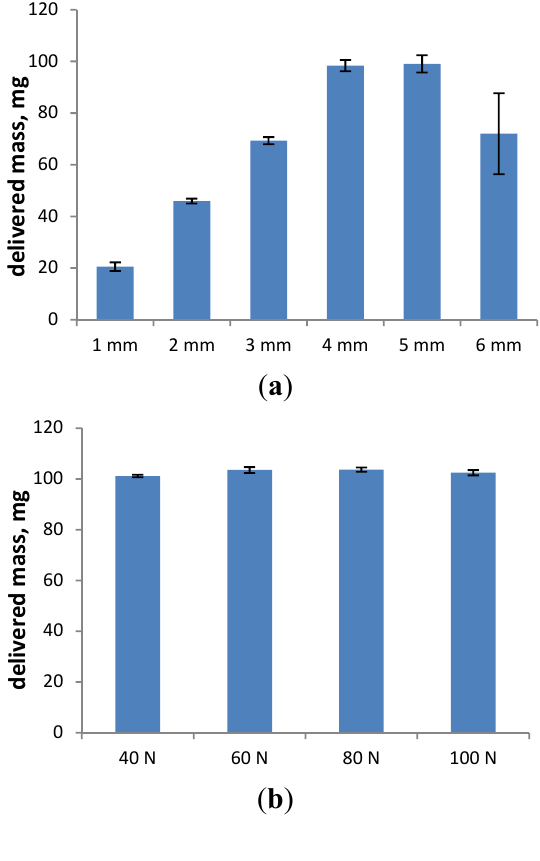
Figure 6. The effect of stroke length varied between 1 and 6 mm ( a ) and actuation force varied between 40 and 100 N; and ( b ) on shot weights. Results represent the average ± SD of at least 90